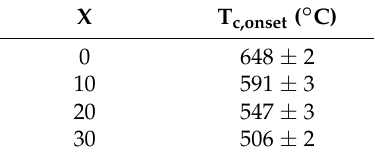
Figure 1. DTA curves of samples (Ni 0.6 Nb 0.4 ) 100−x Zr x for x = 0, 10, 20, and 30, measured with a temperature rate of 10 °C/min.